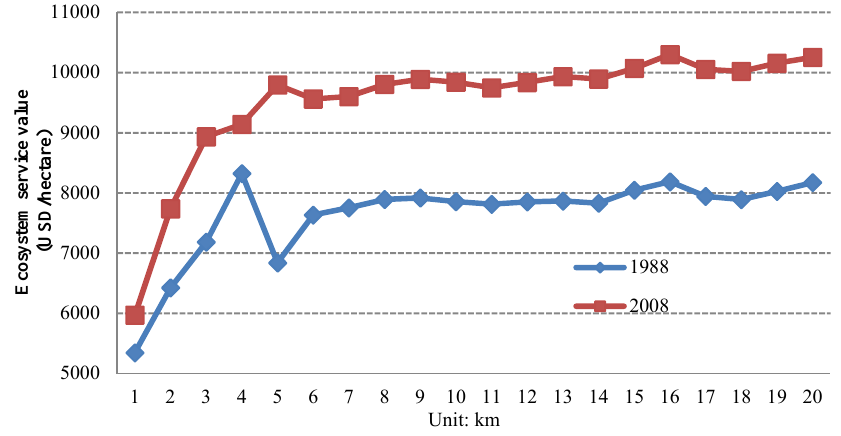
Figure 3. Sensitivity of ESV changes in response to buffer distances in the NCP for both 1988 and